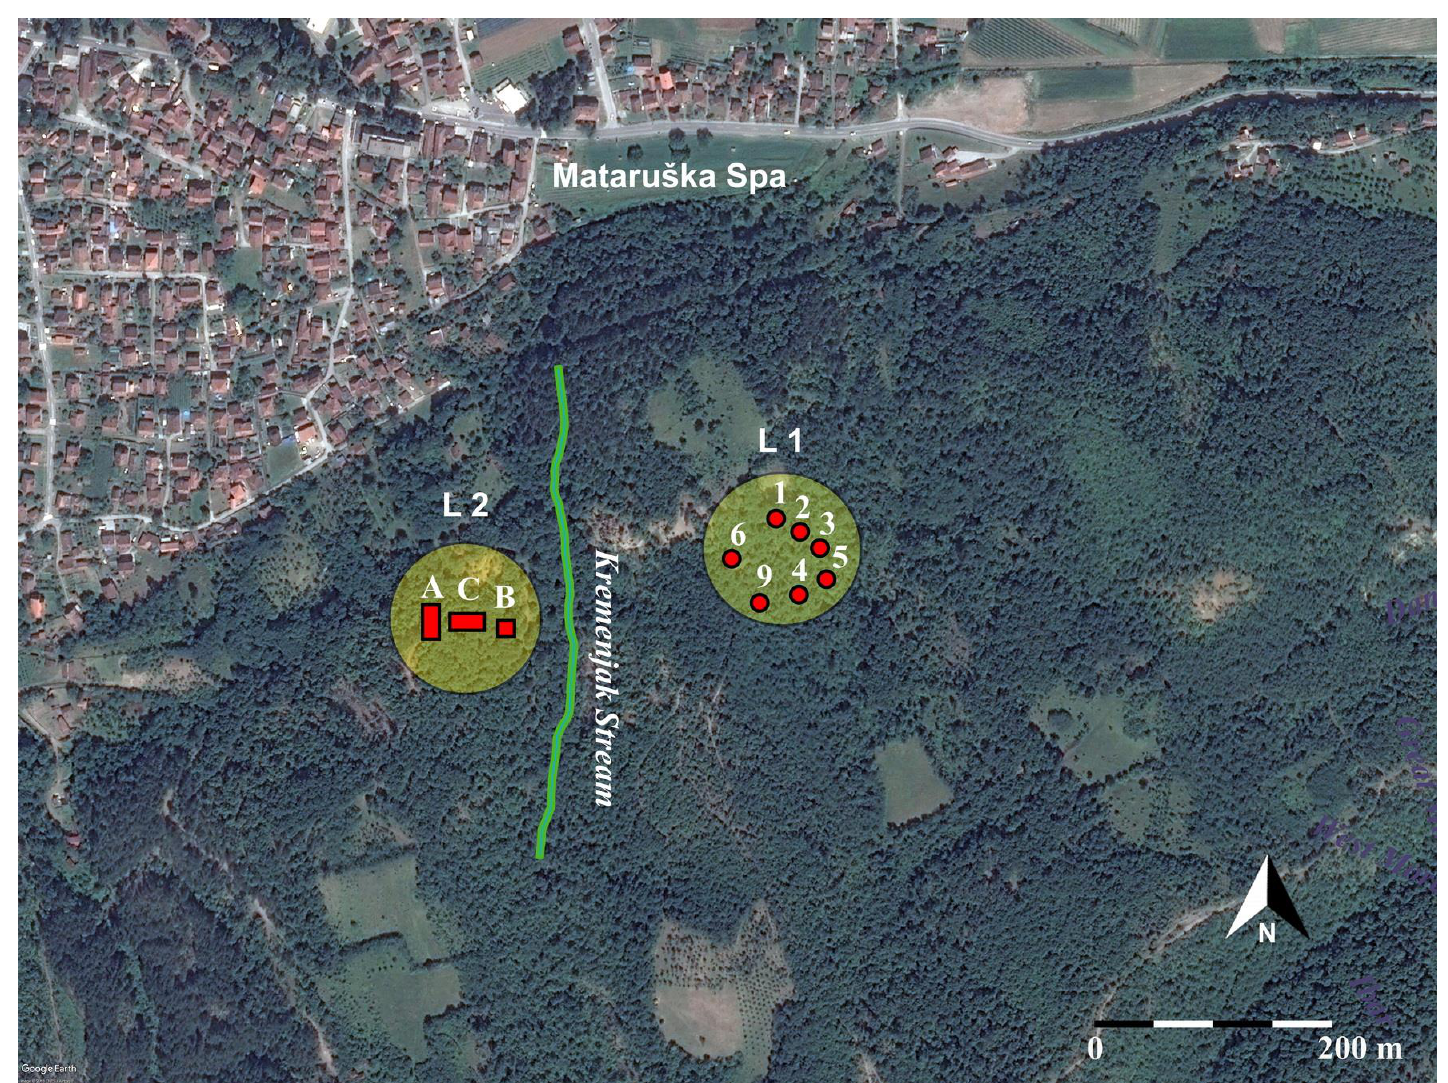
Figure 3. Two zones of archaeological excavation: Lojanik 1 (surface clusters) and Lojanik 2 (Slope 1 with the position of trenches). (From Google Journal of Lithic Studies (2018) vol. 5, nr. 2, p. xx-xx DOI: https://doi.org/10.2218/jls.2804